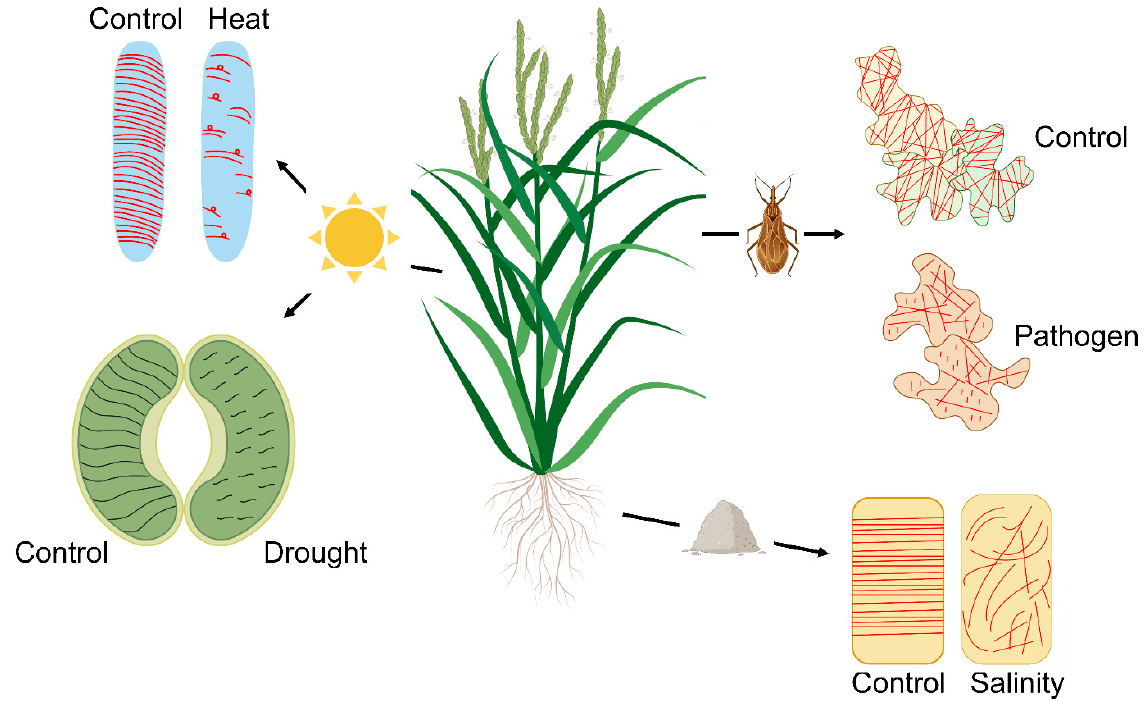
Figure 2. MT networks in response to environmental stresses. Environmental stresses cause the change in MT networks in plant cells. Insets illustrate MT network changes after pathogen infection and treatments for heat, salinity, and drought